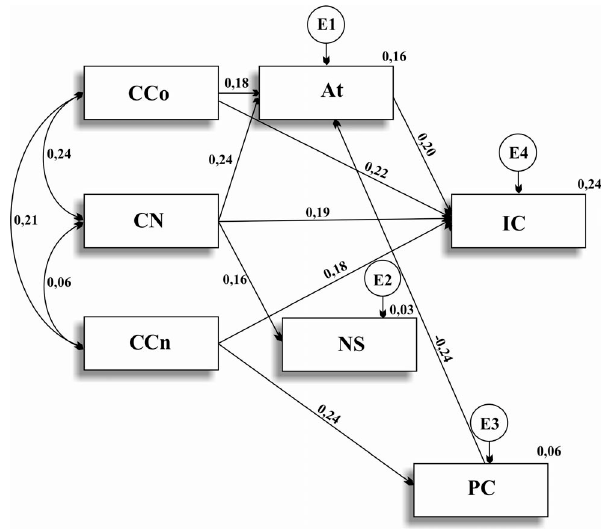
Figura 4. Modelo das relações entre a Atitude (At), Crença Comportamental (CCo), Norma Subjetiva (NS), Crença Normativa (CN), Percepção de Controle (PC), Crença de Con- trole (CCn) e a Intenção Comportamental (IC) para os bene- ficiários do Grupo B Nota. [ χ 2 /gl = 1,02; GFI = 0,98; RMR = 0,05; RMSEA = 0,01 ( IC = 0,00 e 0,08); CFI = 90